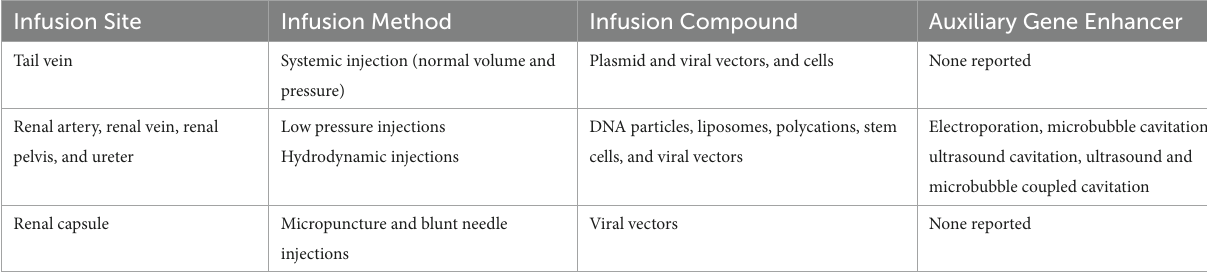
TABLE 1 An overview of delivery methods and associated vectors. Infusion